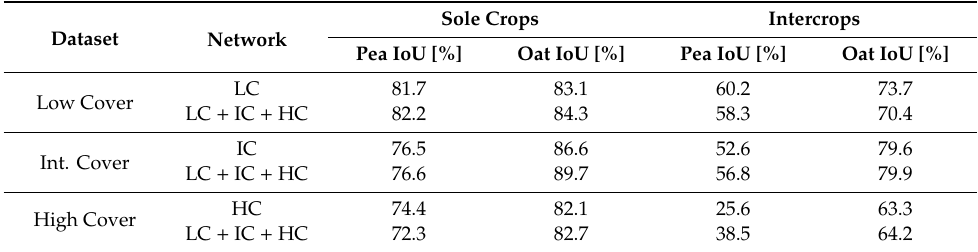
Table 4. Intersection over union (IoU, %) of pea and oat in sole crops and intercrops for the three evaluation datasets (low, intermediate, and high cover) each analyzed by the individually trained network (LC, IC, HC) and the network trained on all datasets (LC + IC + HC).